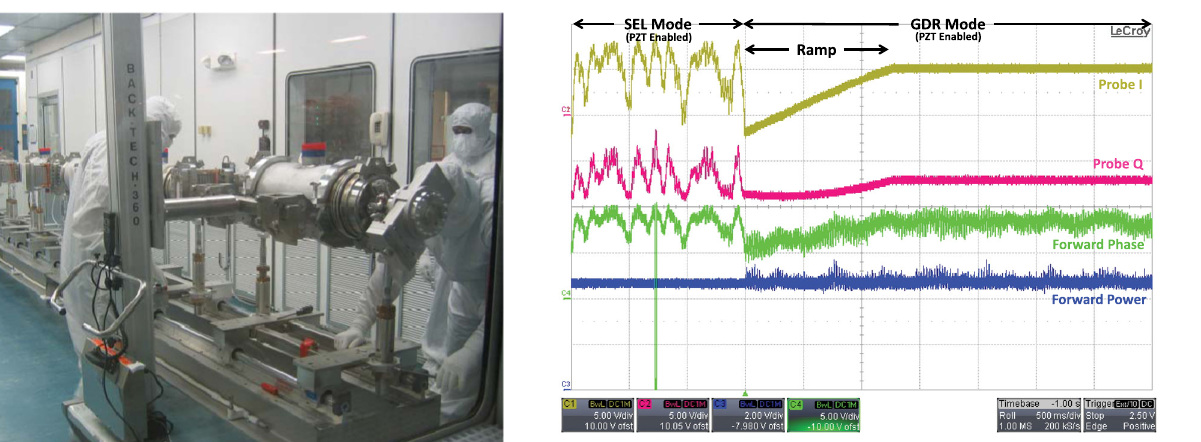
FIG. 29. C100 cavity string assembly.